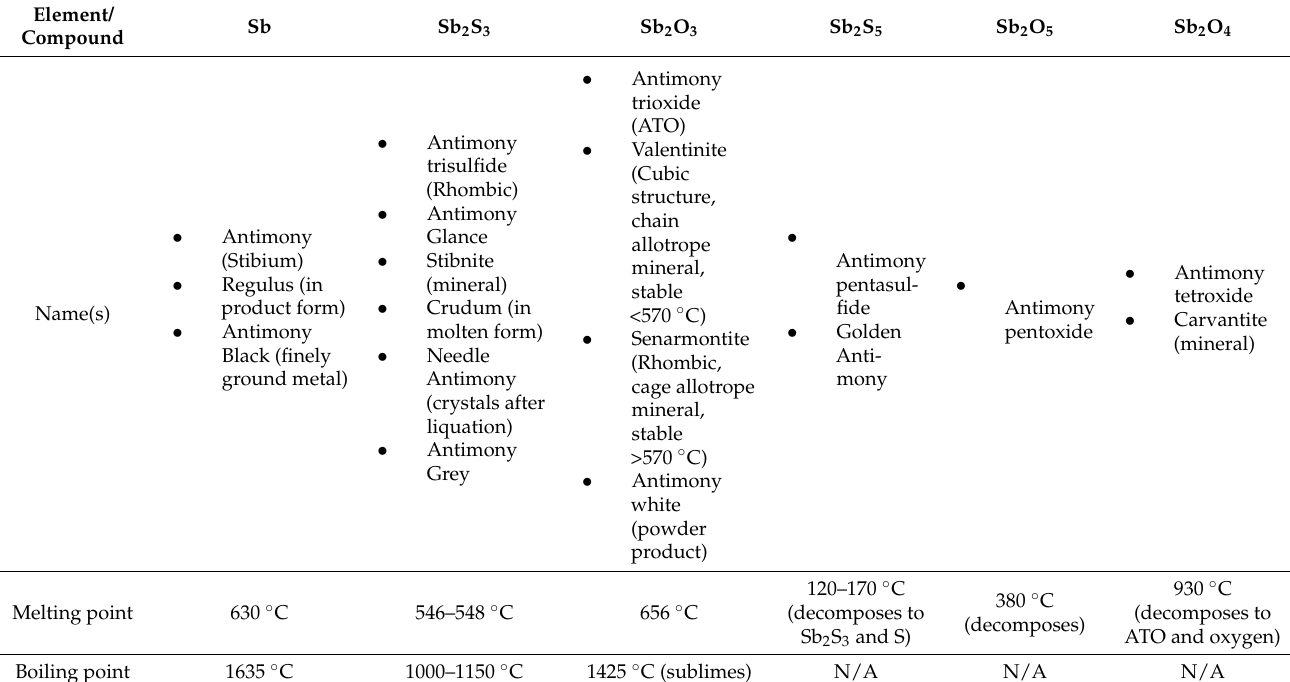
Table 4. Major antimony-containing